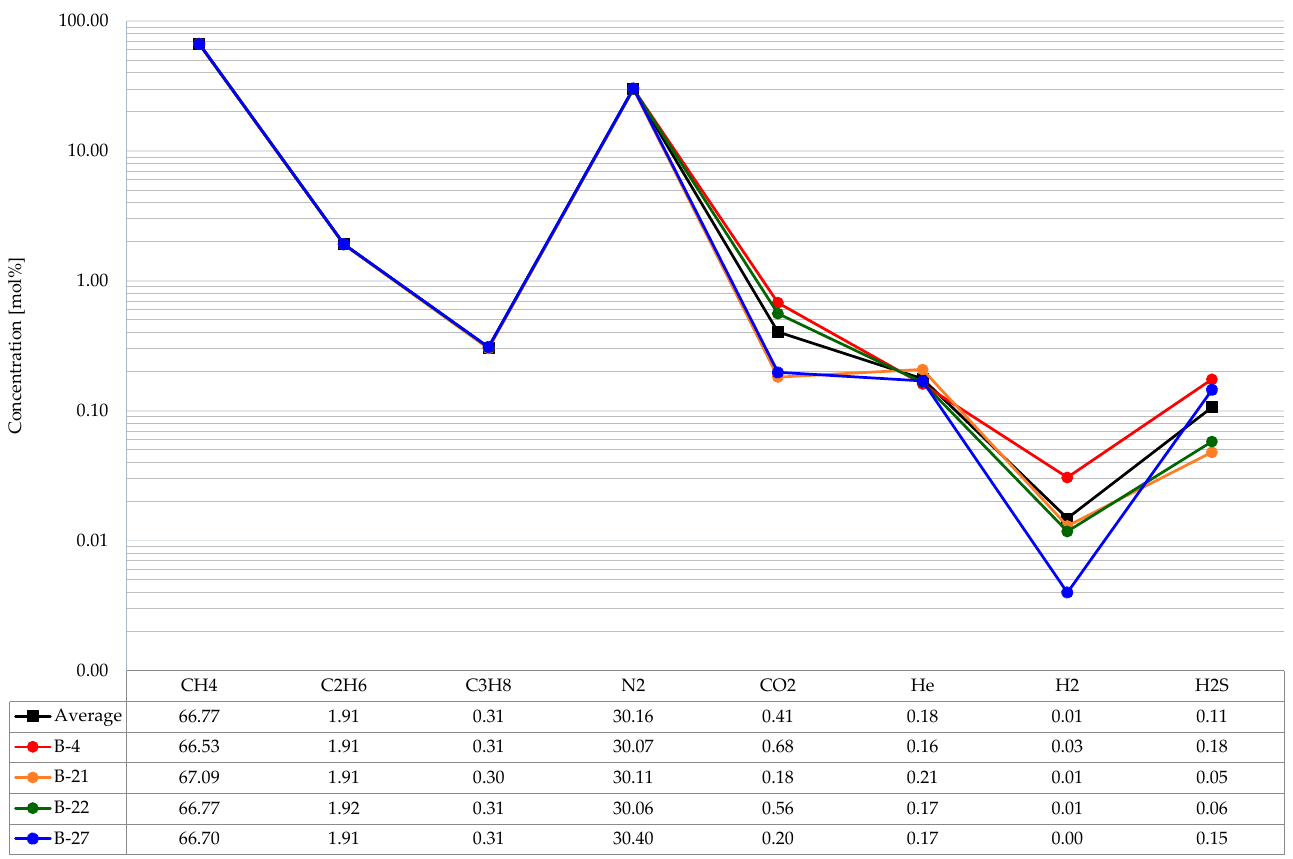
Figure 4. Composition of the produced gas.